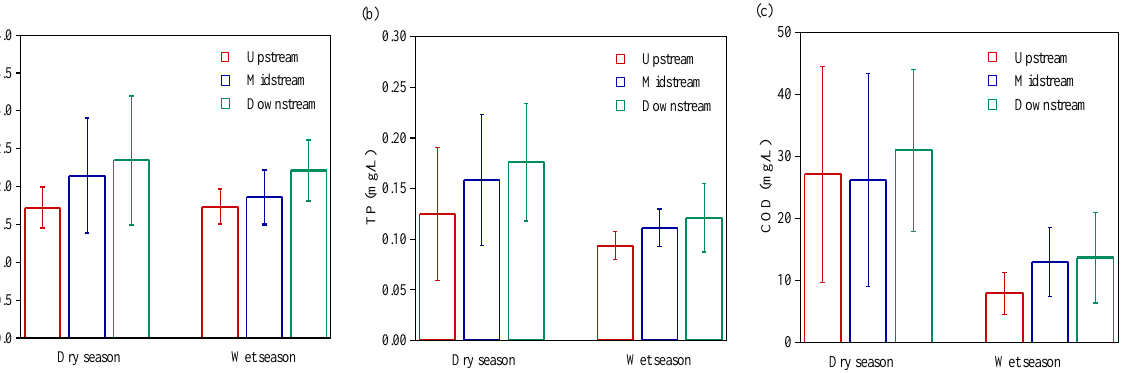
Figure 2. Temporal and spatial distributions of water quality features of the Wanggang River. ( a ) TN; ( b ) TP; ( c ) COD.